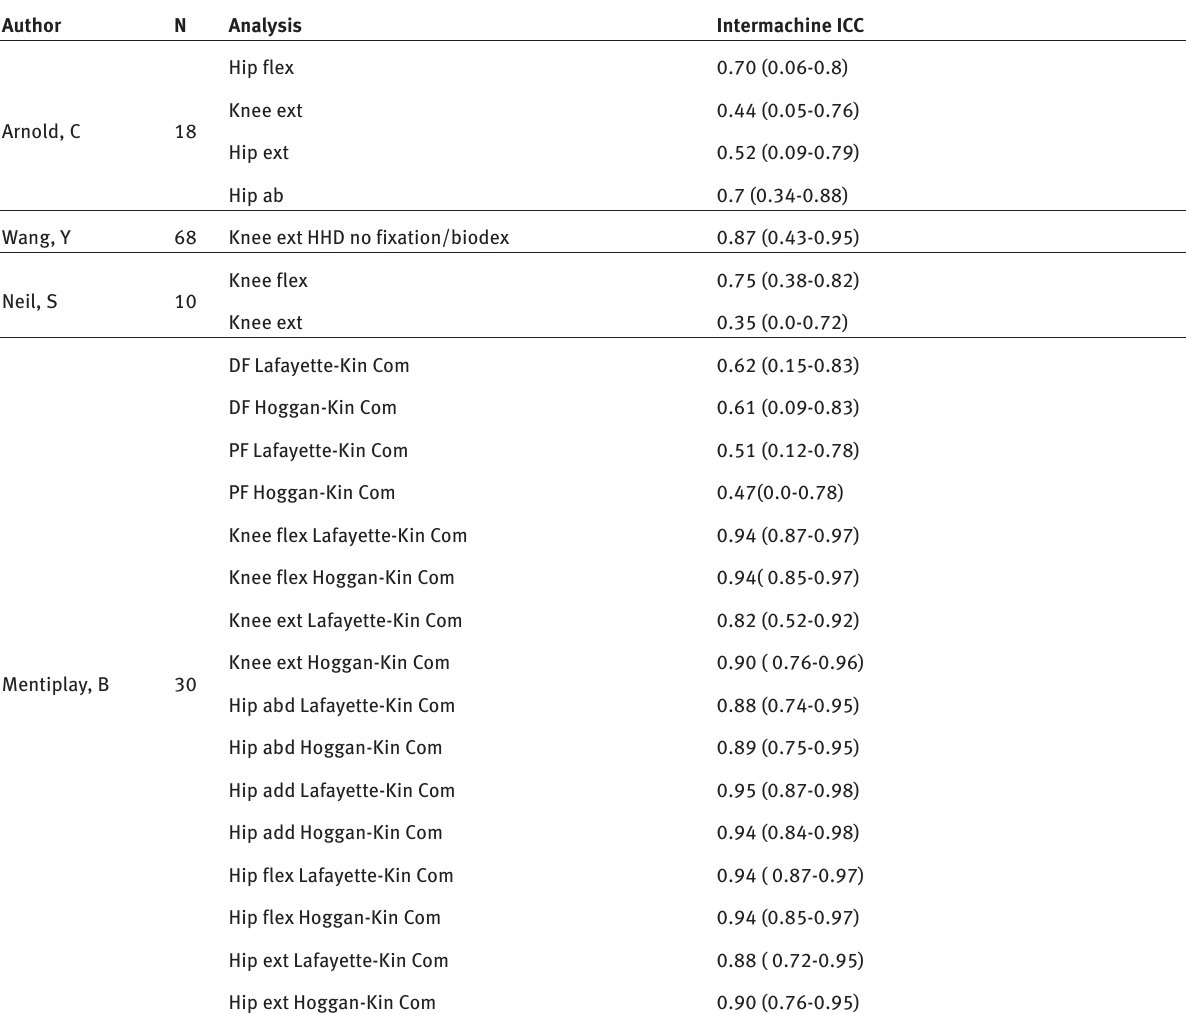
Table 4: Outcomes of selected studies analyzing concurrent validity between HHD and ID.